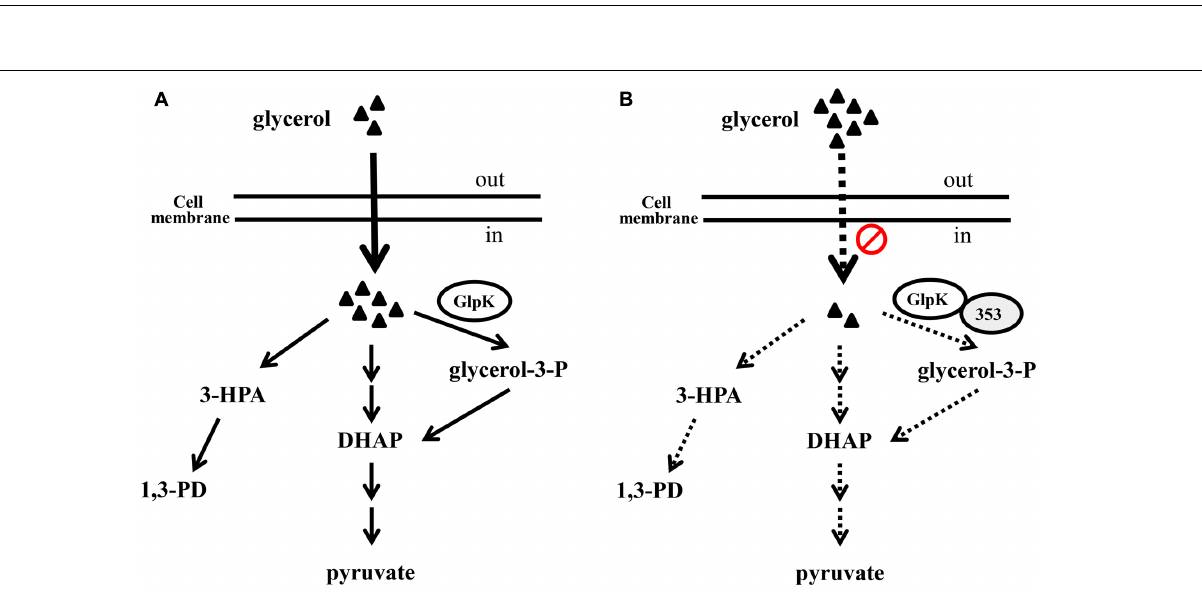
Frontiers in Microbiology |